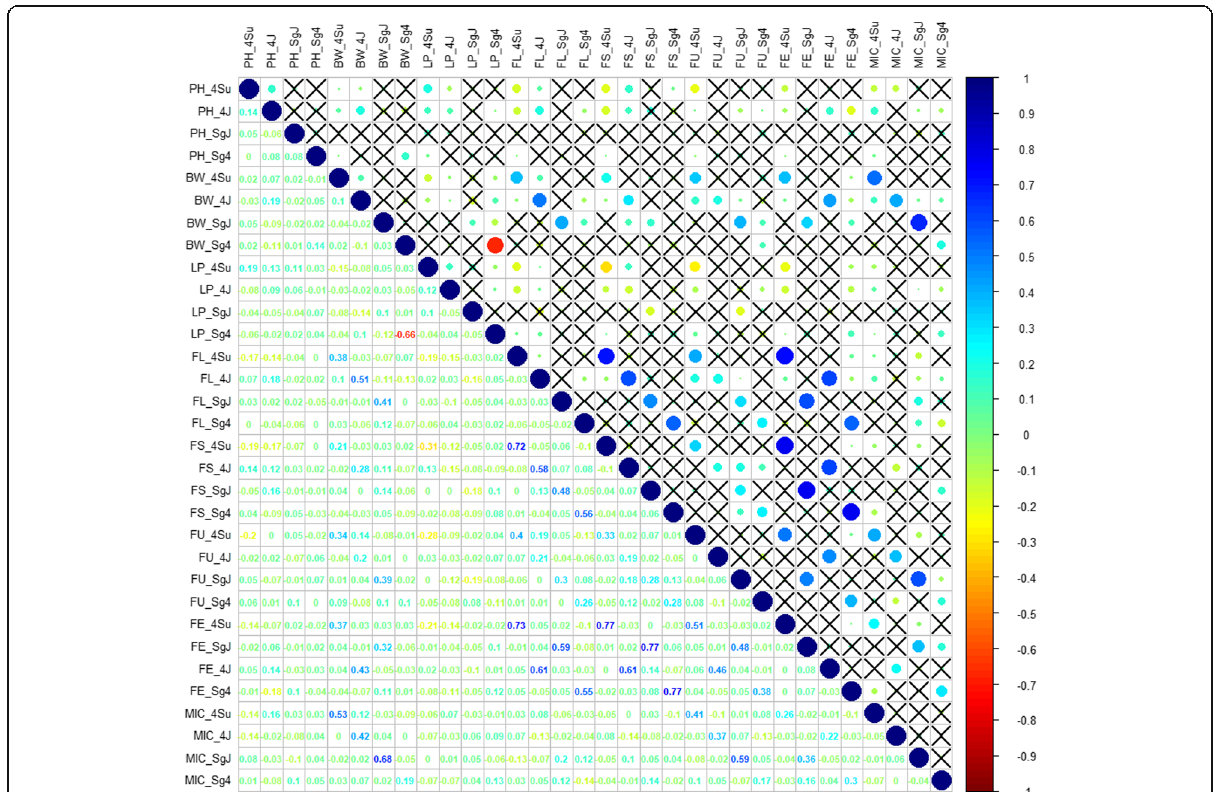
Fig. 2 Correlation analysis among 8 traits. The magnitude of the correlation is indicated by different colors of numbers at the left diagonal and circles at the right diagonal. The circles marked by cross indicate no significant correction was observed between traits ( P >